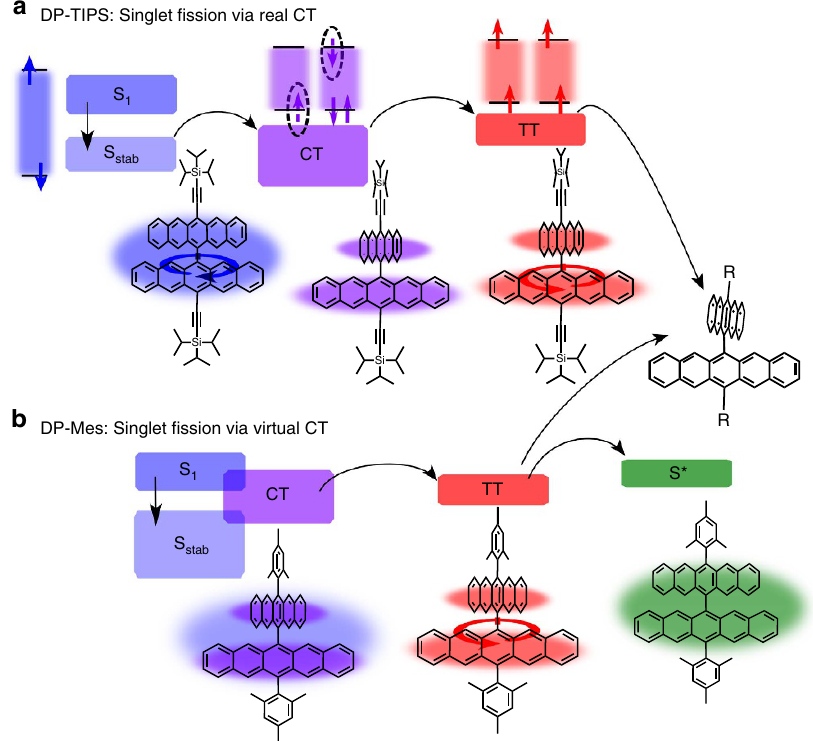
Figure 1 | Tuneable SF pathways in pentacene dimers. In DP-TIPS ( a ), the initial singlet state is rapidly stabilized into a relatively planar geometry S stab . This process is quickly followed by solvent-polarity-dependent CTstate formation, which favours a return to the orthogonal ground-state geometry. The CT state is intermediate to triplet pair (TT) formation. The kinetics of this final SF step depend on polarisation and reconfiguration of the solvent shell, and it is highly efficient in the orthogonal configuration. TT decays via non-radiative geminate recombination. In DP-Mes ( b ), the initial S 1 state is mixed with CT. Direct SF from this singlet state into TT competes with polarity-dependent solvent relaxation into S stab . In non-polar media, subsequent TTA forms a planarized and emissive singlet state S*. In high-polarity media, no radiative TTA is seen and TT only decays by non-radiative geminate recombination. Coloured bars indicate the relative energetic positions of the states involved. Excited-state molecular geometries are inferred from spectroscopic data and comparison to